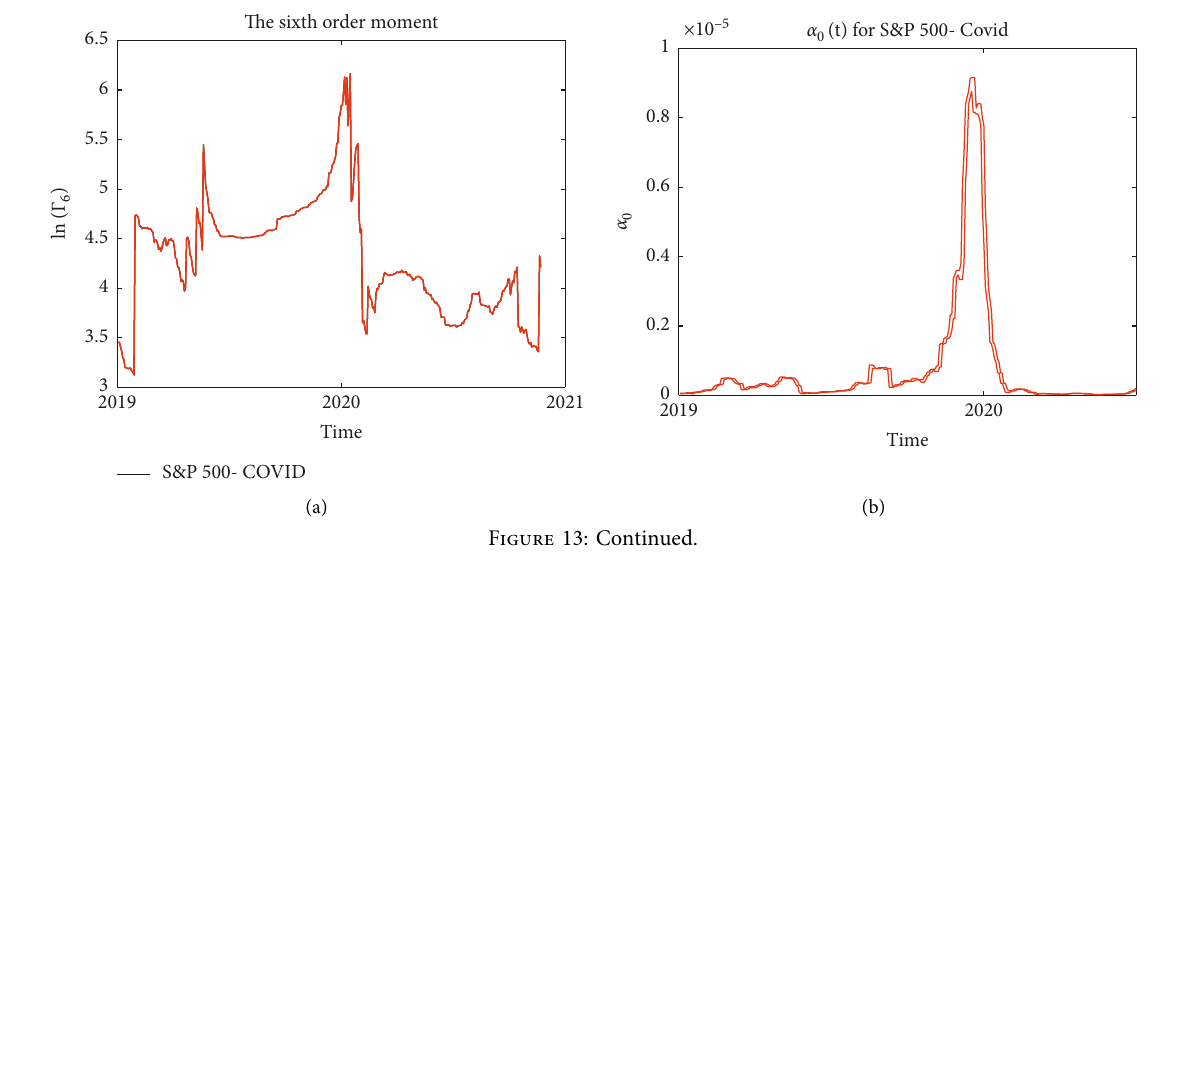
Figure 12: The GARCH parameter’s ( α ) time evolution for Lloyds Bank (a), Barclays Bank (b), and the Bank of America (c) for the period 0 signal for a crisis period. There is a very high peak of the parameter value around the start of the 2019–2021. In all panels, we see the typical α 0 crisis period. In all time series analysed, we detail the error interval for the parameter’s value, using the method described previously.